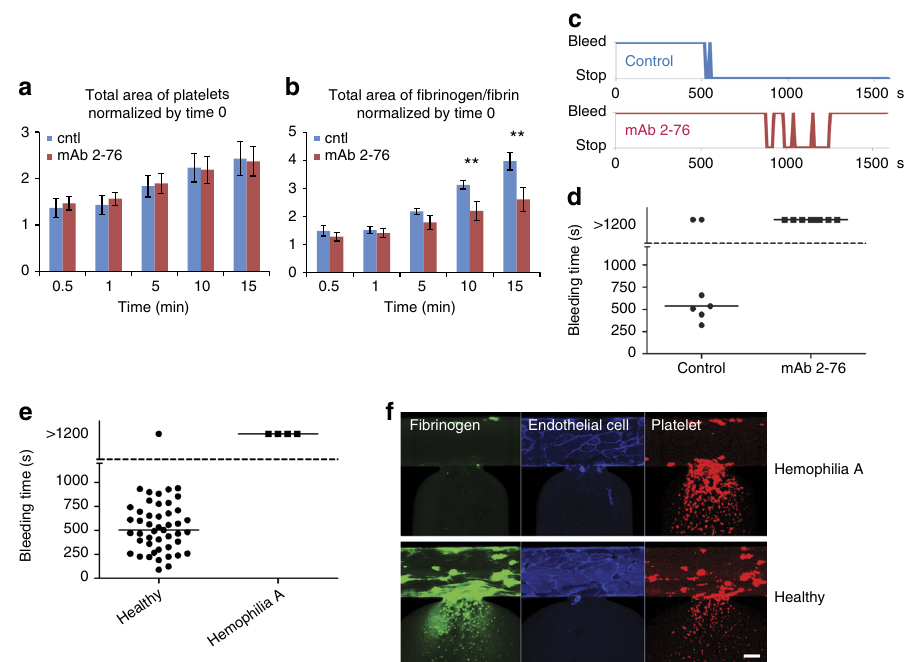
Fig. 5 Inhibition of factor VIII and blood from hemophilia A patients reduce fi brinogen/ fi brin accumulation at the injury site and impair hemostasis. a When healthy blood was treated with an antibody against A2 domain of Factor VIII (mAb 2 – 76), there was no difference in the total surface area of adhered platelets at the injury site compared to that of vehicle control conditions. b However, inhibition of factor VIII resulted in a signi fi cant reduction of fi brinogen/ fi brin accumulation at later time points (10 and 15 min after the mechanical injury). The error bars in the graphs show standard errors (control n = 4, mAb 2 – 76 n = 4). Double asterisk (**) shows P -value < 0.05 by Student's t -test. c Antibody-treated blood sample exhibited “ re-bleeding ” and failed to achieve hemostasis during the entire experimental time frame ( d ). e Severe hemophilia A patient blood samples also failed to achieve hemostasis and continued bleeding over the entire experimental time course. f Fibrinogen/ fi brin accumulation (green) was also markedly decreased in severe hemophilia A patient blood samples at the wound site as compared to that of healthy control blood, although platelet (red) adhesion and accumulation were similar between the two conditions. Scale bar = 50 µ m. Bars in graphs represent median